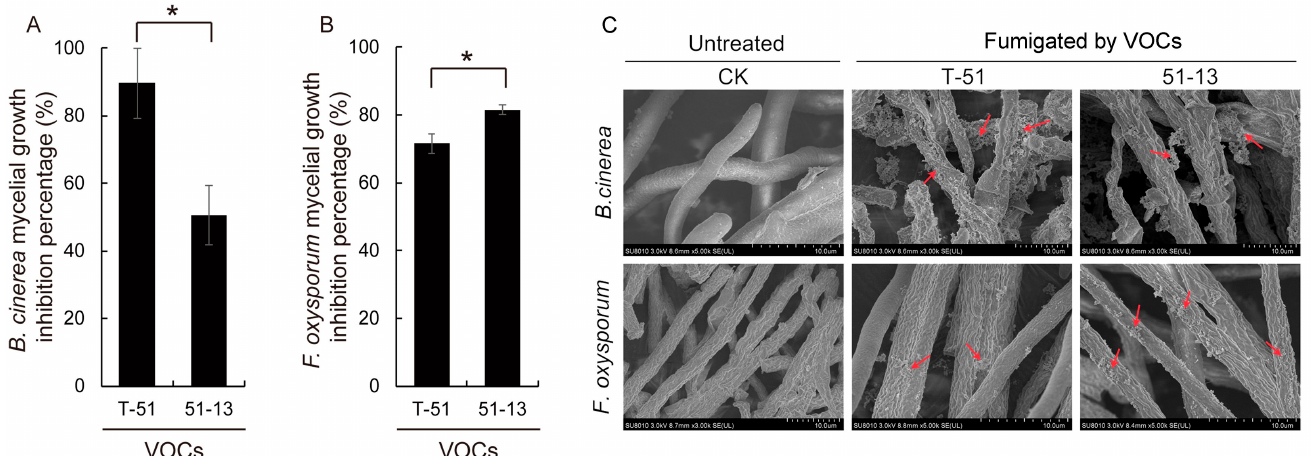
Figure 3. Images obtained by scanning electron microscopy showing the mycelial morphology of B. cinerea growing on PDA media (CK) and PDA added with the CF of T-51 or 51-13 (10% v / v ).